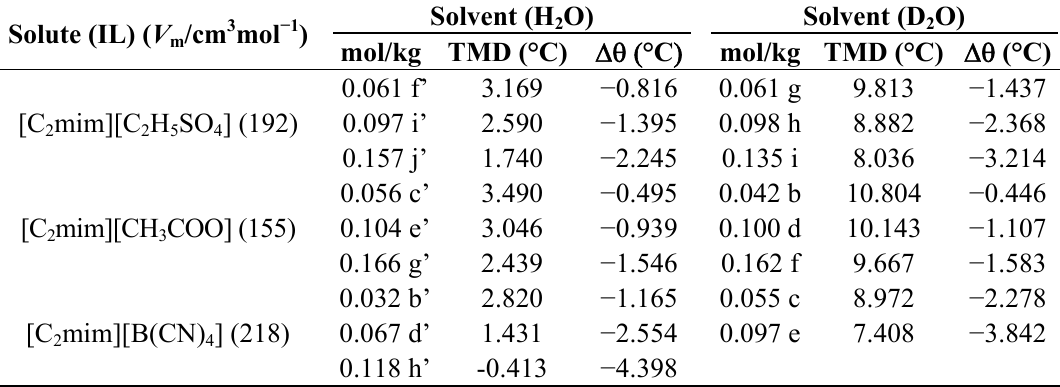
Table 2. TMD results for all studied ionic liquid aqueous solutions. Solutions were prepared in molal concentrations. The alphabetical labels correspond to those in Figures 1 and